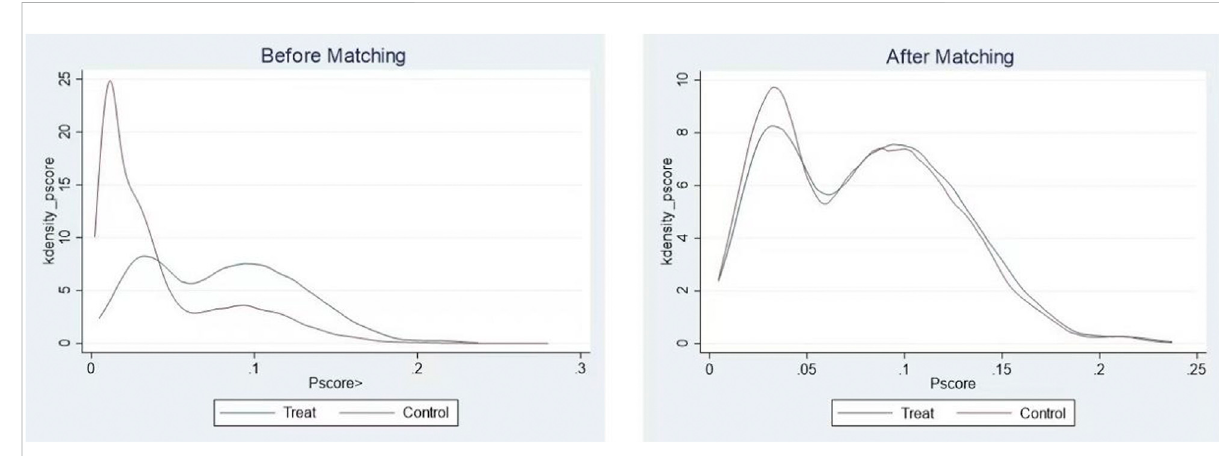
FIGURE 1 Kernel density distributions of natural hazards before and after matching. The blue line represents households that received the speci fi ed intervention. The red lines represent households that did not receive the speci fi ed intervention.